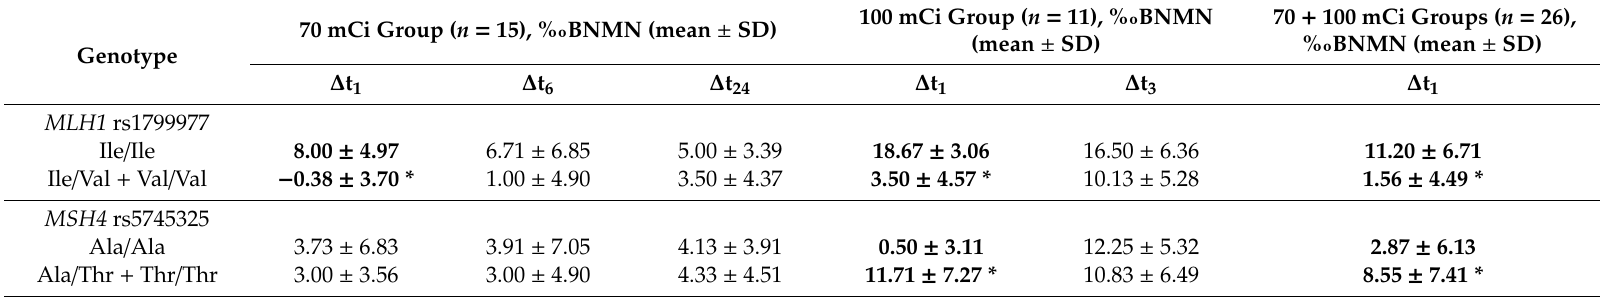
Table 5. Variation in the frequency of micronucleated cells from baseline (% (cid:24) BNMN, mean ± SD) in each 131 I dose group at t 1 , t 3 / t 6, and t 24 , according to genotype (only SNPs presenting significant findings are